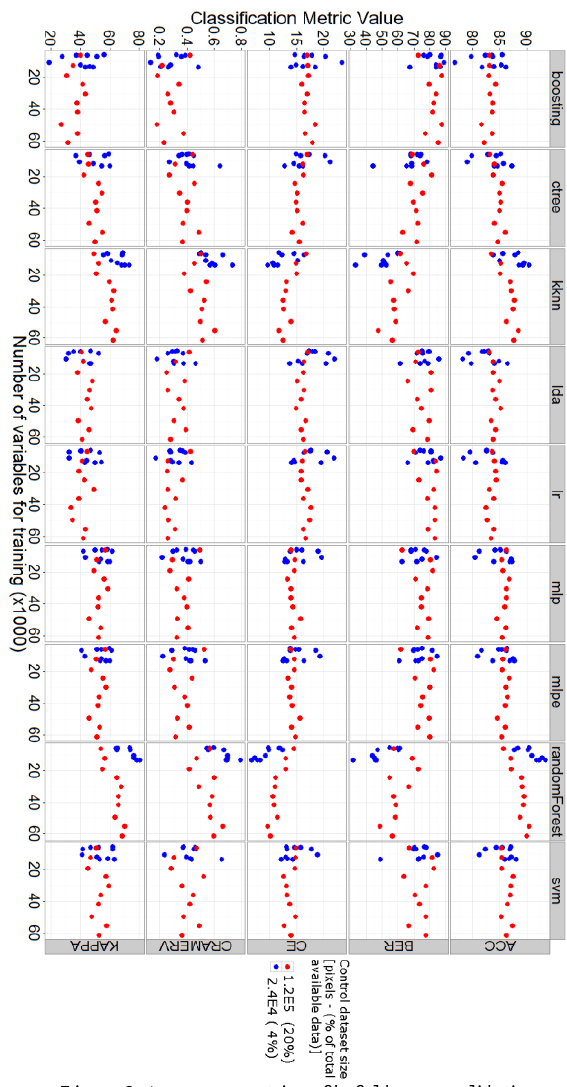
Figure 2. Accuracy metrics of k-fold cross validation over the training set.